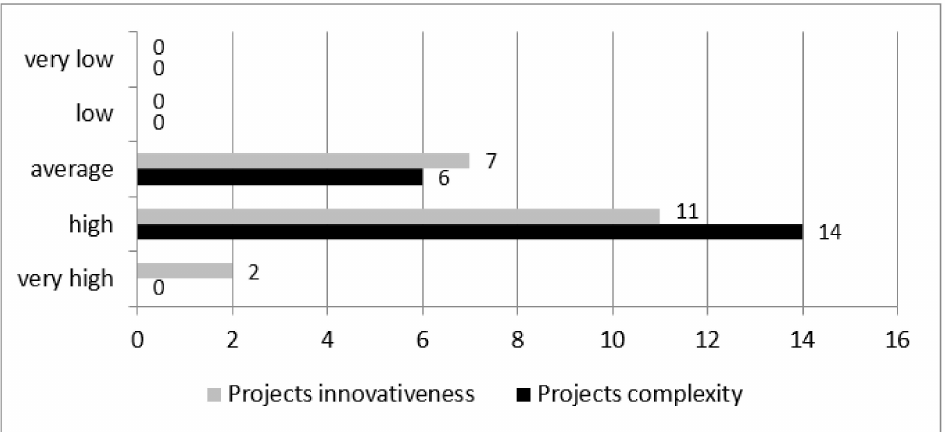
Figure 1. Assessment of the degree of difficulty/complexity and innovation of the performed